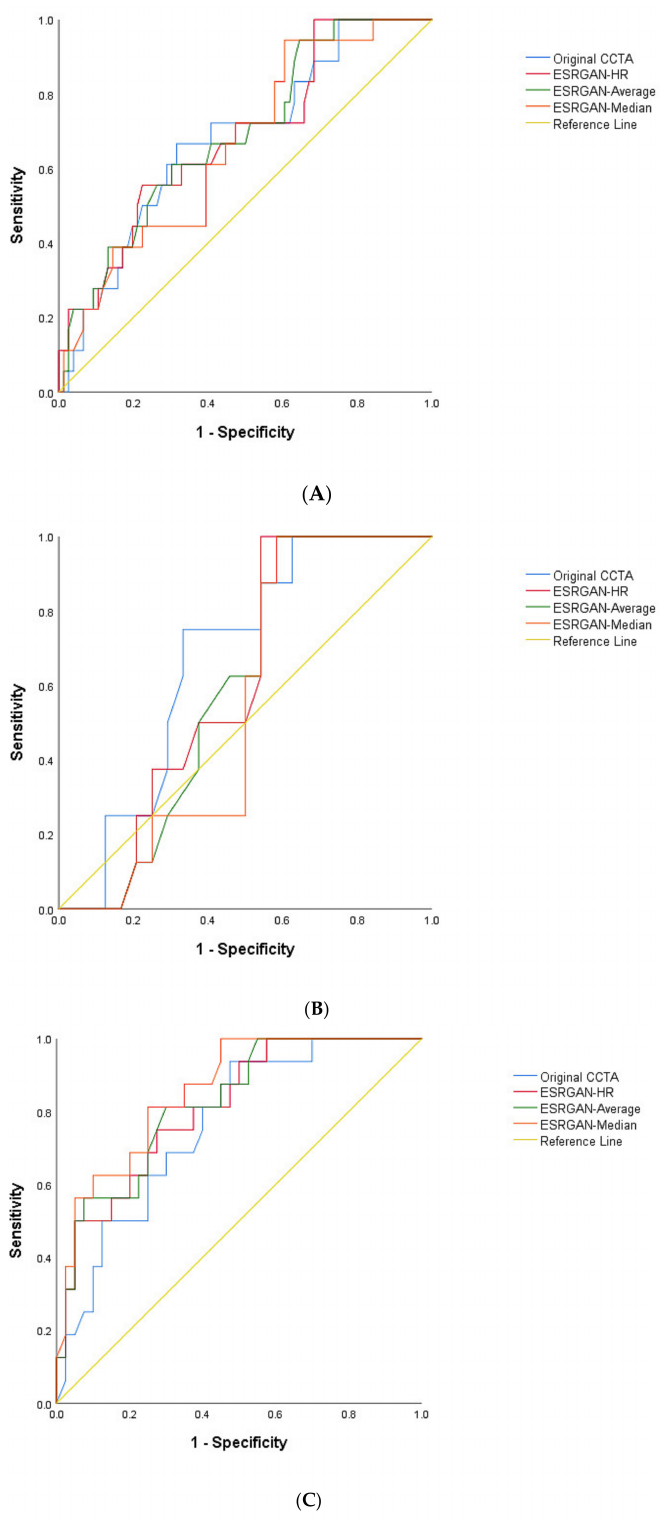
Figure 3. Area under the receiver operating characteristic curve (AUC) between original CCTA and ERSGAN-processed images at LAD, LCx and RCA ( A – C ). The AUC was the highest at the RCA level with value ranging from 0.81 to 0.86 for ESRGAN-processed images than the 0.76 for original CCTA images. CCTA-coronary computed tomography angiography; ESRGAN-enhanced super-resolution generative adversarial network; HR-high-resolution; LAD-left anterior descending; LCx-left circumflex; No.-number; RCA-right coronary